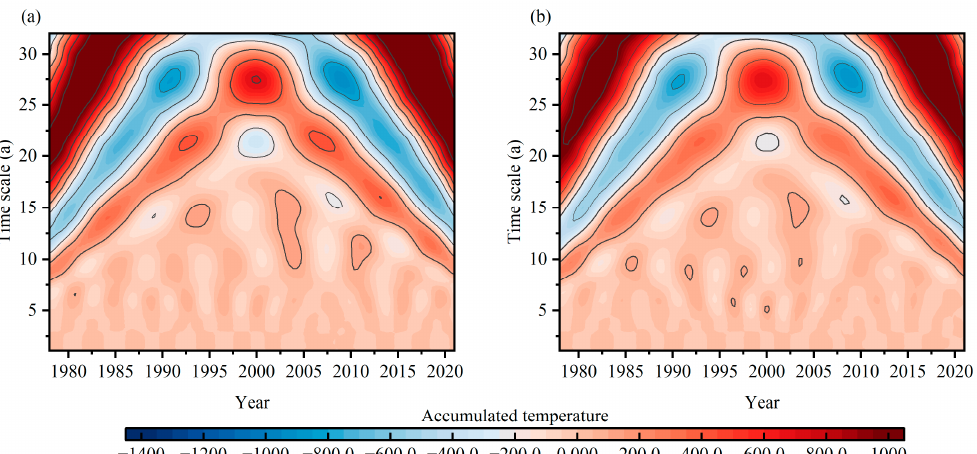
Figure 3. The wavelet transform coefficient graph of accumulated temperature in Henan Province from 1978–2021 at the annual scale. ( a ) represent ≥ 0 °C accumulated temperature, and ( b ) represent ≥ 10 °C accumulated temperature.